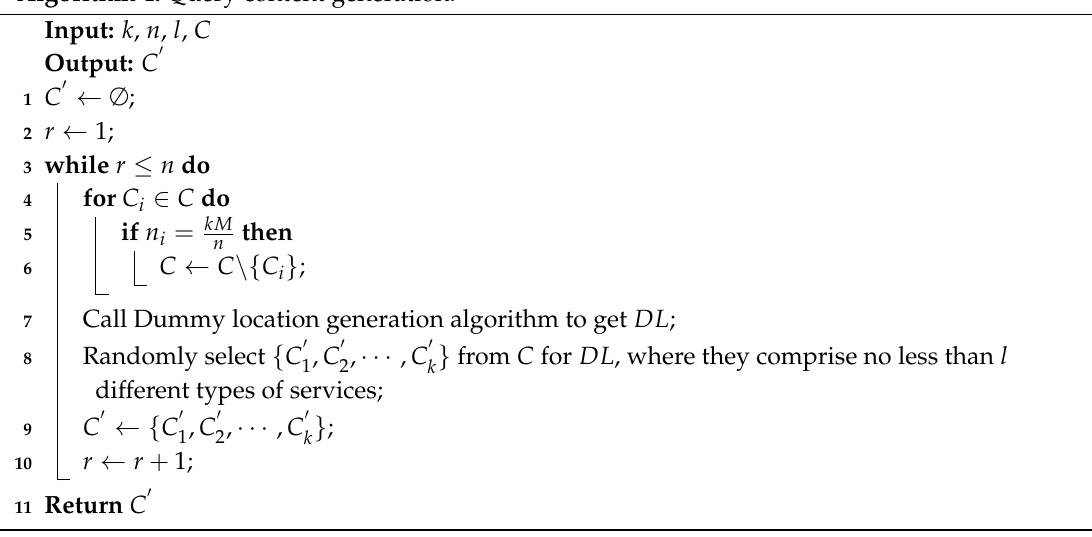
Algorithm 4: Query content